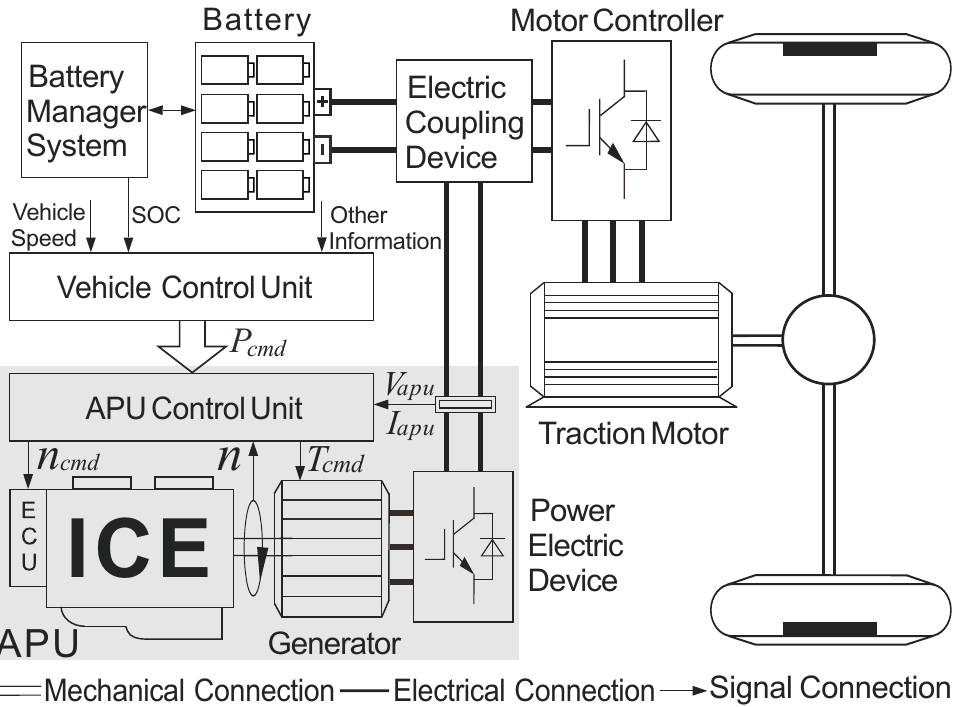
Figure 1. Schematic of the auxiliary power unit (APU) and its application in series hybrid electric vehicle (SHEV). Internal combustion engine: